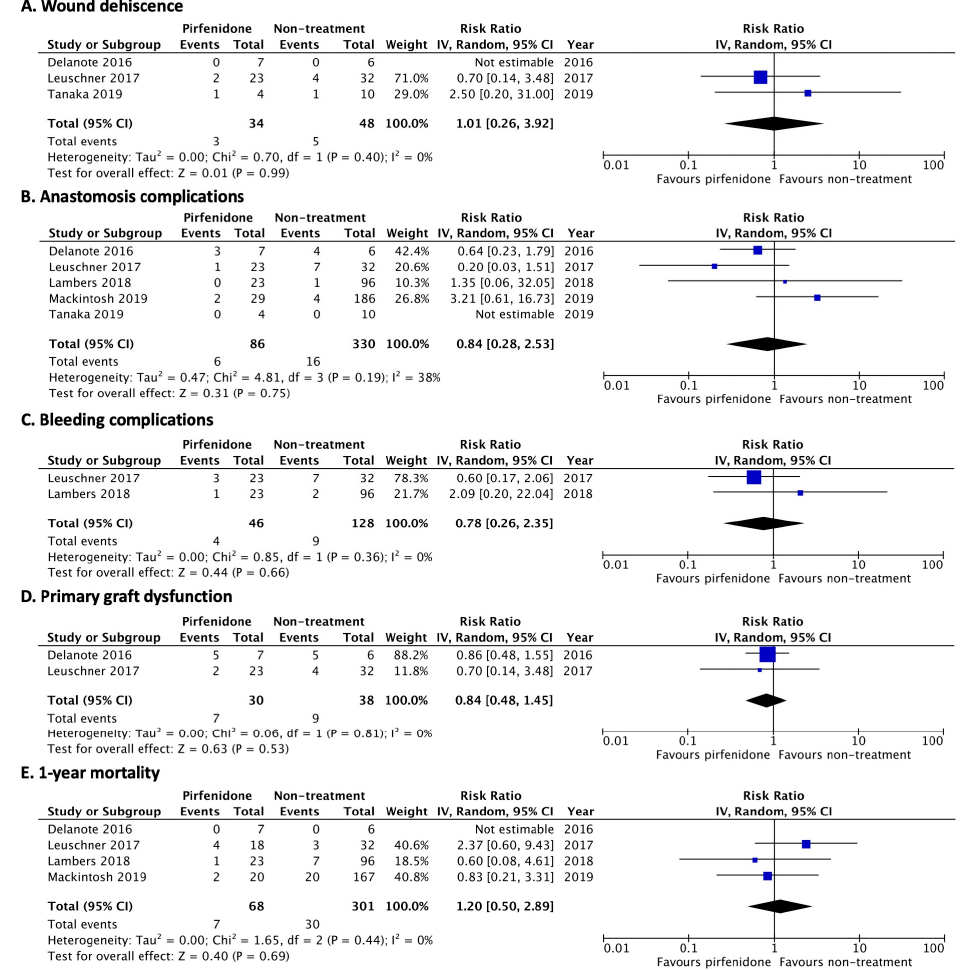
Figure 4. Forest plot of pooled risk ratio for pirfenidone [12,21–24]. ( A ) surgical wound dehiscence, ( B ) anastomosis complications, ( C ) bleeding complications, ( D ) primary graft dysfunction at 72 h after transplantation, and ( E ) 1-year mortality after LT.